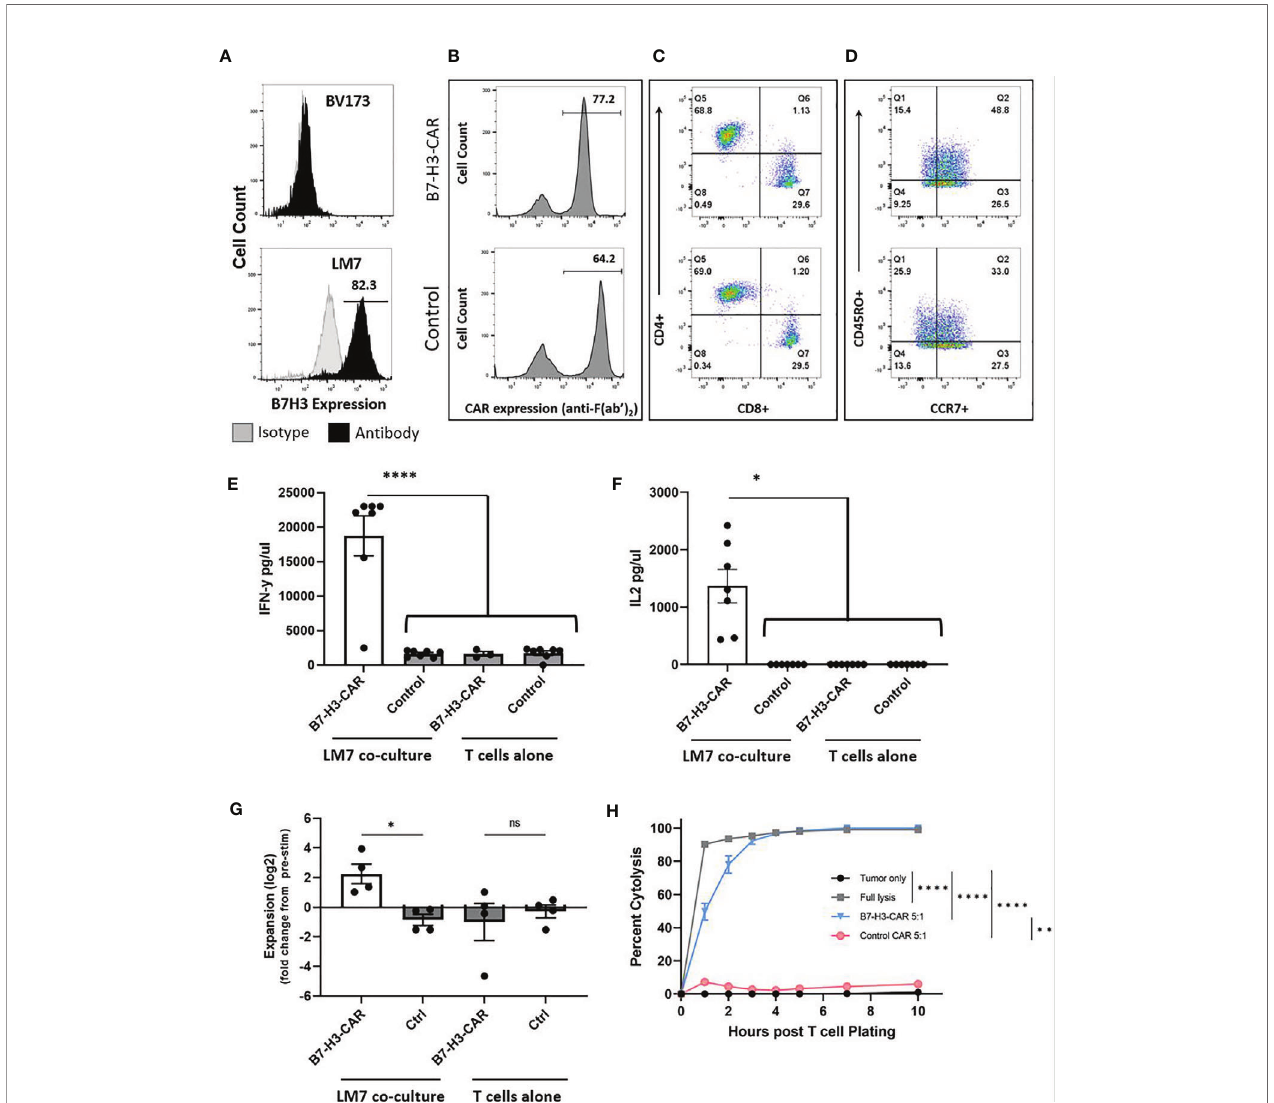
FIGURE 2 | LM7 OS B7-H3 expression, CAR T cell transduction, phenotype, and in vitro effector function. (A) The LM7 OS cell line was evaluated by fl ow cytometry for surface B7-H3 expression and shows robust expression. BV173 cells served as known negative controls. Activated T cells were transduced with lentiviral particles encoding B7-H3.CD28 z CARs or a control CAR (B7-H3.CD8 a . D ). B-D) Representative fl ow plots of transduced T cells. (B) Percent transduction of B7-H3-CAR and control CAR T cells. (C) CAR T cell CD4+/CD8+ phenotype. (D) CAR T cell CD45RO+/CCR7+ memory phenotypes. E-F) CAR T cells were placed in coculture with LM7 tumor cells or plated alone at a 1:1 effector:target ratio. After 24 hours, supernatant was removed and assessed by ELISA for cytokine production. B7-H3-CAR T cells demonstrated robust (E) IFN- g (p < 0.0001) and (F) IL-2 (p < 0.05) production. N = 7 donors; performed in duplicate. Statistical analysis by one-way ANOVA. (G) CAR T cells were placed in coculture with LM7 tumor cells or plated alone and fold change from baseline quanti fi ed as described in the text (N = 4 donors; performed in duplicate; p < 0.05; statistical analysis by one-way ANOVA). (H) Impedance-based cytotoxicity assay (xCELLigence) using LM7 cells as targets demonstrated robust cytotoxicity of B7-H3-CAR T cells compared to controls (N = 4 donors; E:T ratio = 5:1; statistical analysis by AUC and one-way ANOVA; *p < 0.05; **p < 0.01; ****p < 0.0001). ns, not signi fi